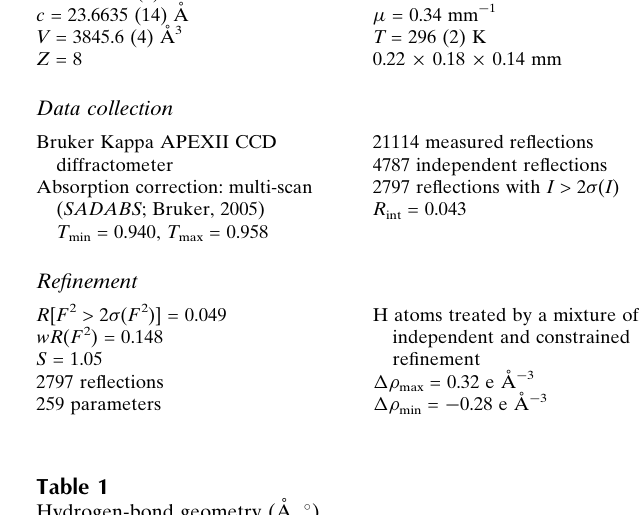
Hydrogen-bond geometry (A˚ , (cid:4)